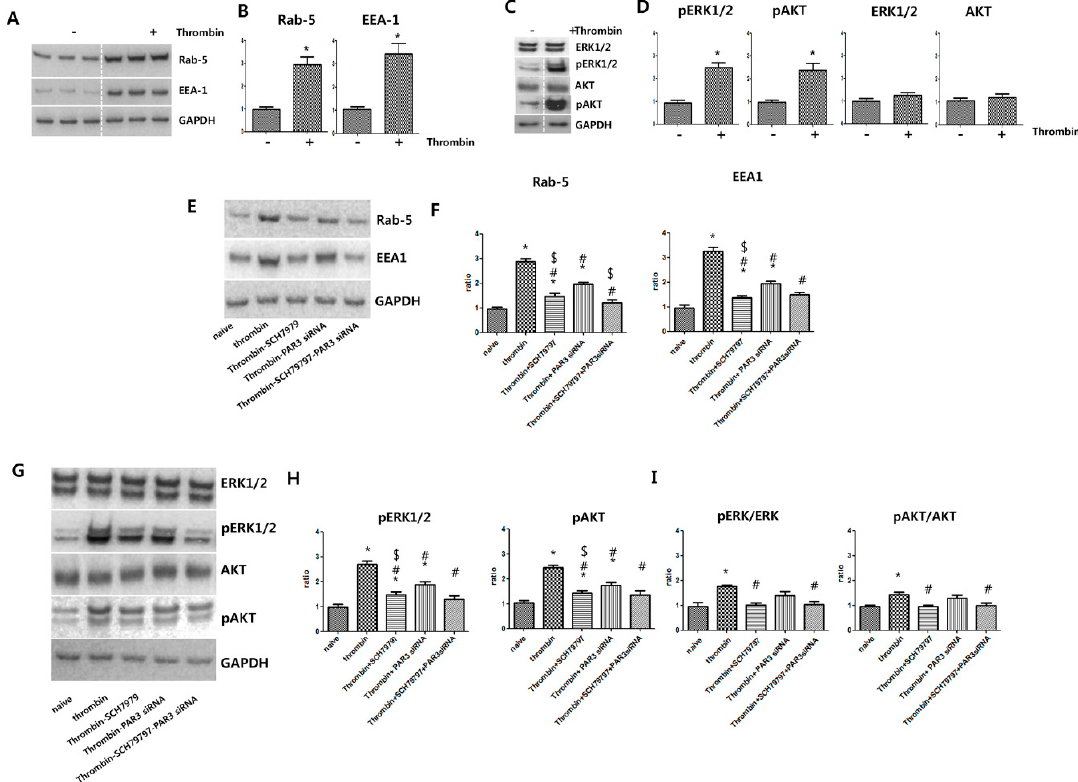
Figure 3. Protease-activated receptors, PAR1 and PAR3, are involved in extracellular vesicle production and phosphorylation of ERK and AKT in umbilical cord-derived mesenchymal stem cells after thrombin preconditioning. Thrombin-preconditioned umbilical cord-derived mesenchymal stem cells (UCB-MSCs) were lysed for immunoblotting analysis with the indicated antibodies. ( A ) After thrombin treatment and inhibition, changes in the protein levels of endosome markers in the UCB-MSCs were assessed by immunoblotting. ( B ) Bar graph showing quantification of Rab-5 and EEA1 levels. ( C ) After thrombin treatment and inhibition, changes in the protein levels of phosphorylated (p)ERK1 / 2, p AKT, ERK1 / 2, and AKT in the UCB-MSCs were assessed by immunoblotting. ( D ) Bar graph showing quantification of p ERK1 / 2 p AKT, ERK1 / 2, and AKT. ( E ) After thrombin treatment and inhibition, changes in the levels of endosome markers in the UCB-MSCs were determined by immunoblotting. ( F ) Bar graph showing quantification of Rab-5 and EEA1 levels. ( G ) After thrombin treatment, changes in the expression of p ERK1 / 2 and p AKT in the UCB-MSCs were determined by immunoblotting. ( H ) Bar graph showing quantification of p ERK1 / 2 and p AKT levels. ( I ) Bar graph showing quantification of the ratio of p ERK / ERK and p AKT / AKT. Data are presented as mean ± SD. An asterisk (*) indicates a significant di ff erence vs. naive EVs, a number sign (#) indicates a significant di ff erence vs. thrombin-treated UCB-MSC and, a dollar sign ($) indicates a significant di ff erence vs. thrombin + PAR3 siRNA UCB-MSCs ( p < 0.05, two-sample t -test; n = 5 per analysis).